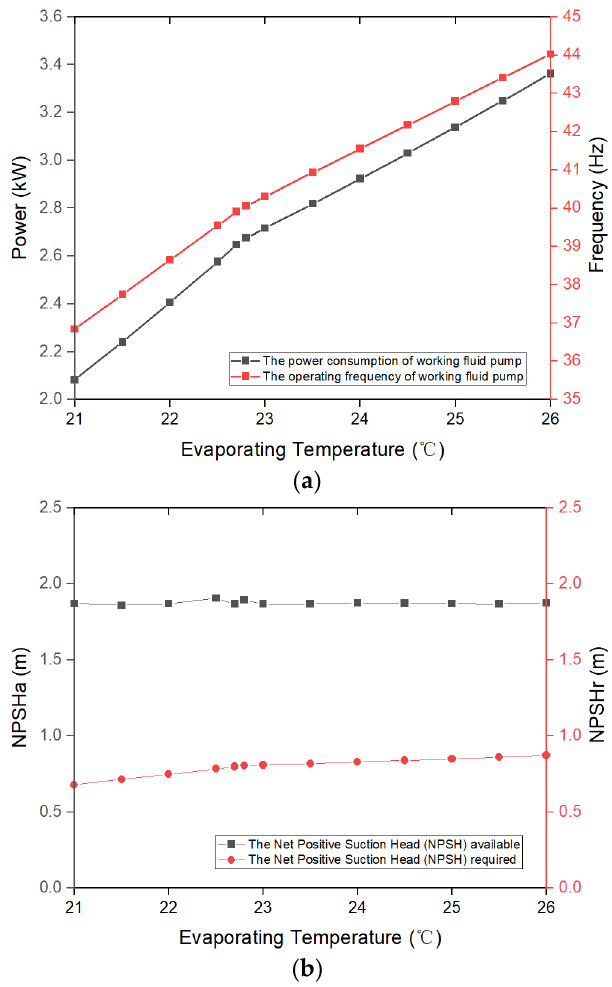
Figure 8. The results for the working fluid pump. ( a ) The power and operating frequency of the working fluid pump. ( b ) The NPSHa and NPSHr of the working fluid pump. working fluid pump. ( b ) The NPSHa and NPSHr of the working fluid